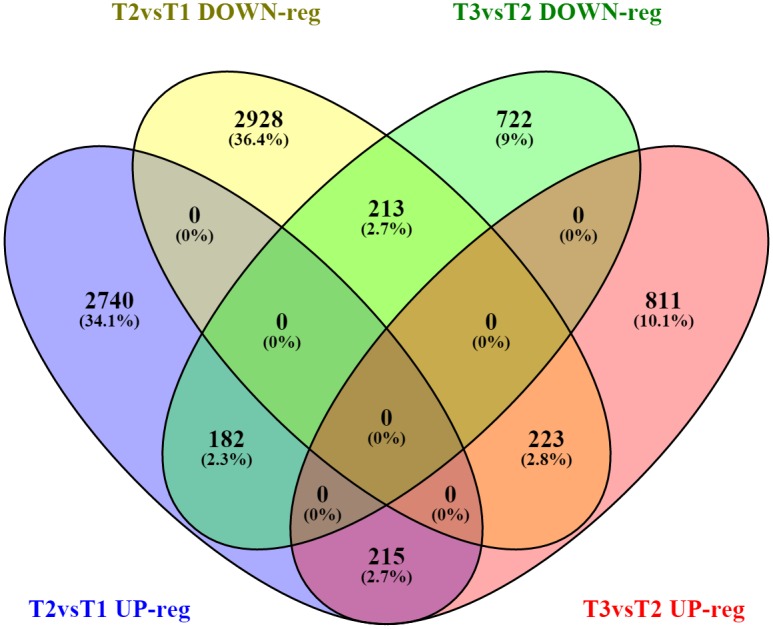
Venn diagram showing the numbers of DEGS identified from T2vsT1 and T3vsT2.Overlap comparison of DEGS from two comparisons (T2vsT1 and T3vsT2) according to direction of expression. Sets of up- / down- regulated genes of T2vsT1 are represented in blue and yellow, up- / down- regulated genes of T3vsT2 in pink and green.